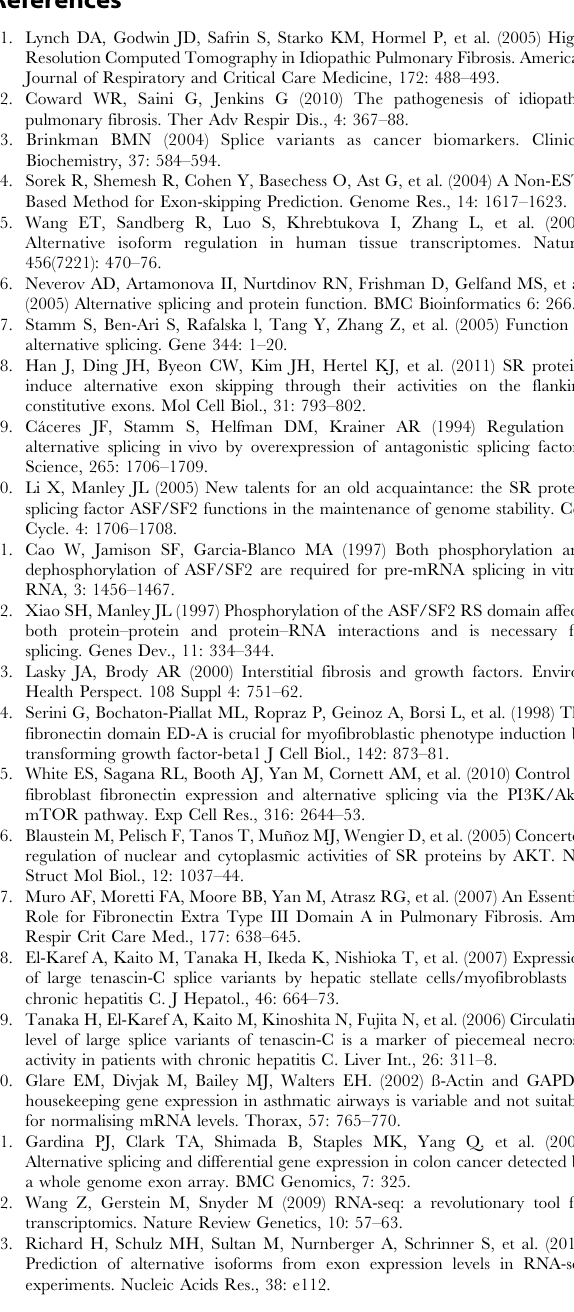
Table S2 Annotation of 35 genes with annotated and novel transcripts. Table S3 Analysis results of differential expression and differential splicing of 35 genes with novel transcripts. Table S4 Comparison results between our study and a published dataset. Table S5 Demographic and biological factors of IPF and control samples.